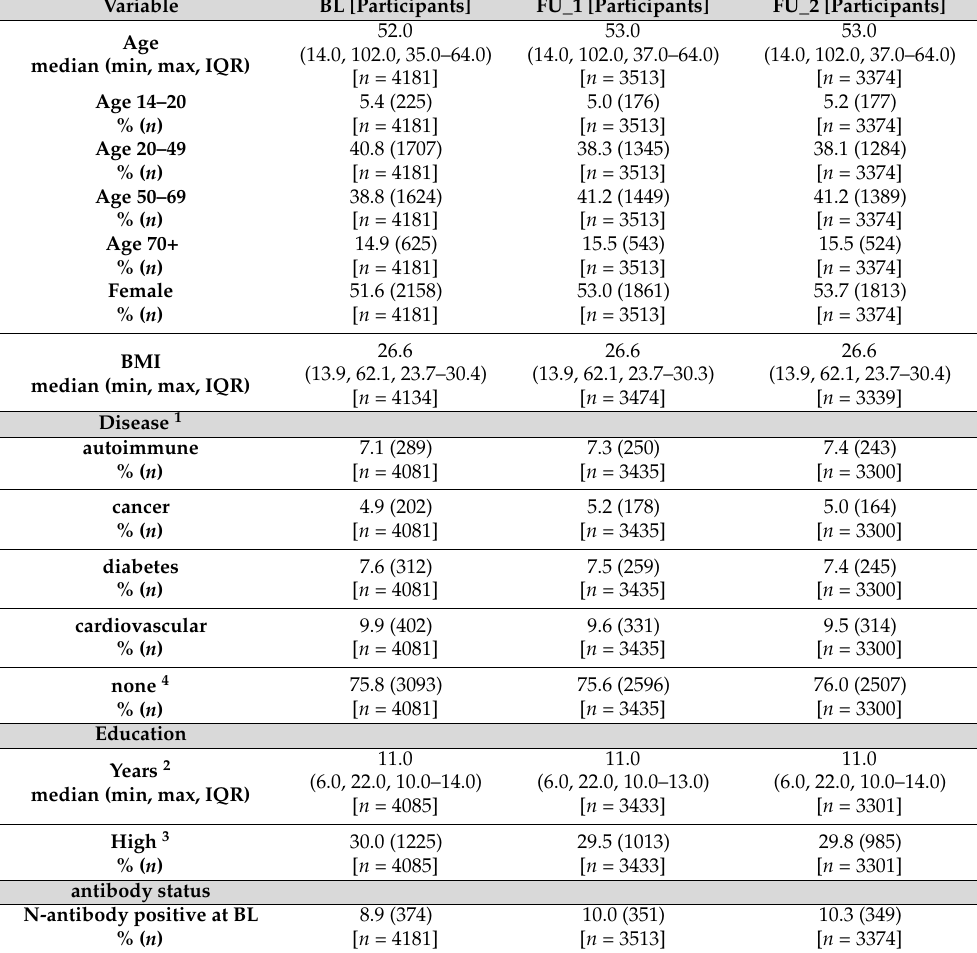
Table 1. Participant characteristics. Shown are, as indicated, median and IQR or percentage and number of individuals for the given characteristic for analyzable participants at BL, FU1, and